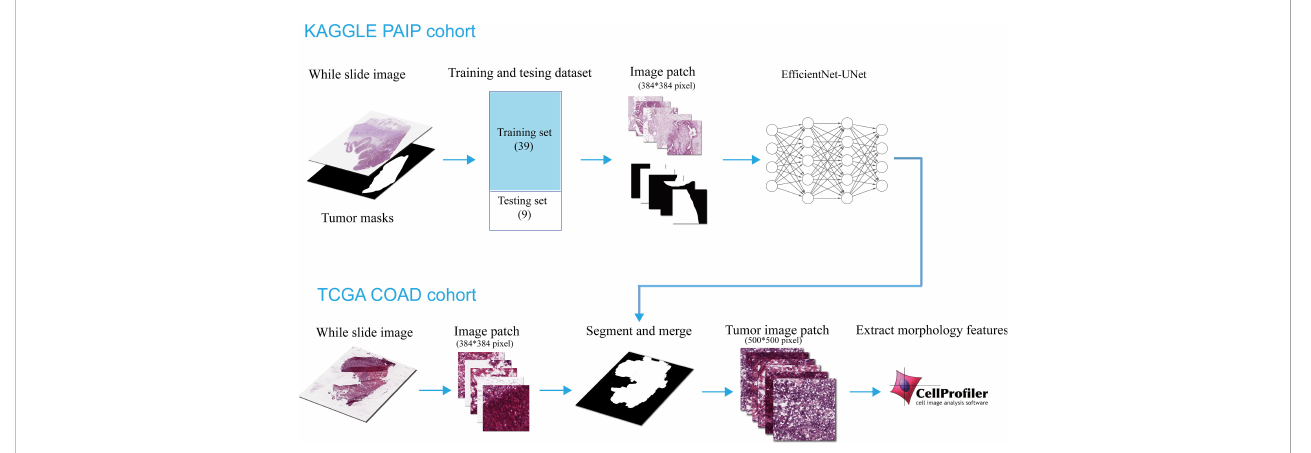
FIGURE 1 Flowchart of the construction and use of the tumor region segmentation deep learning model.